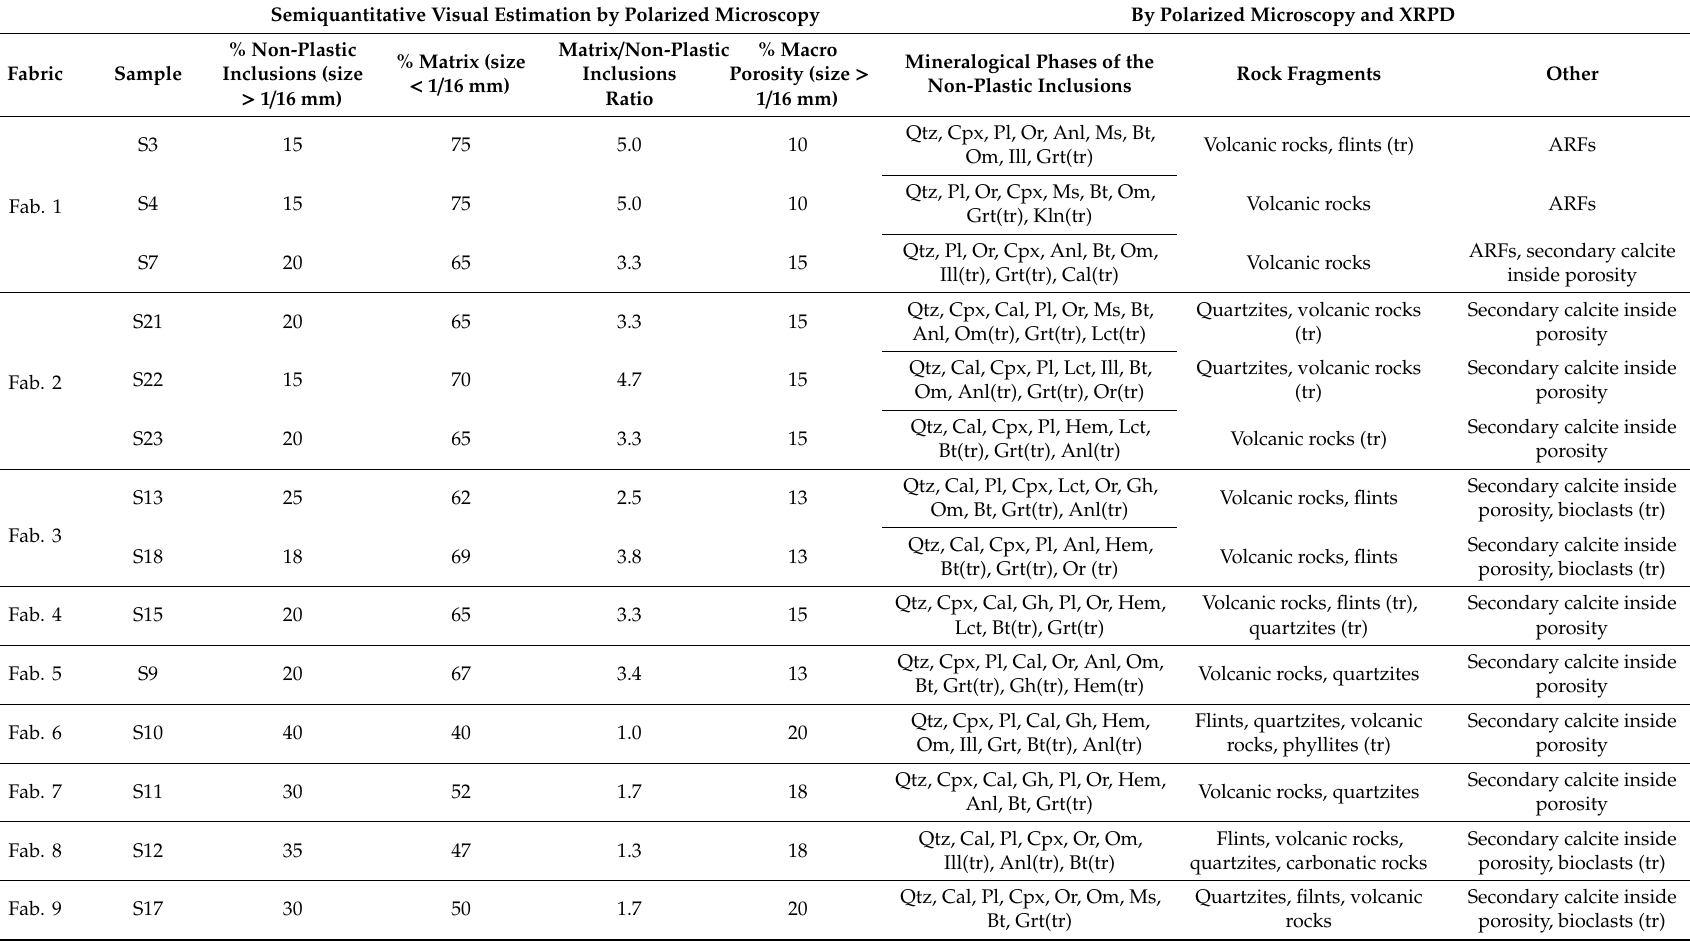
Table 3. Mineralogical and petrographic features of the architectural earthenwares by optical microscopy and Semiquantitative visual estimation of non-plastic inclusions, matrix and macroporosity. Mineralogical phases = Anl: analcime, Bt: biotite, Cal: calcite, Cpx: clinopyroxene; Gh: gehlenite, Grt: garnet, Hem: hematite, Ill: illite, Kln: kaolinite, Lct: leucite, Ms: muscovite, Om: opaque minerals, Or: orthoclase, Pl: plagioclase, Qtz: quartz. tr: